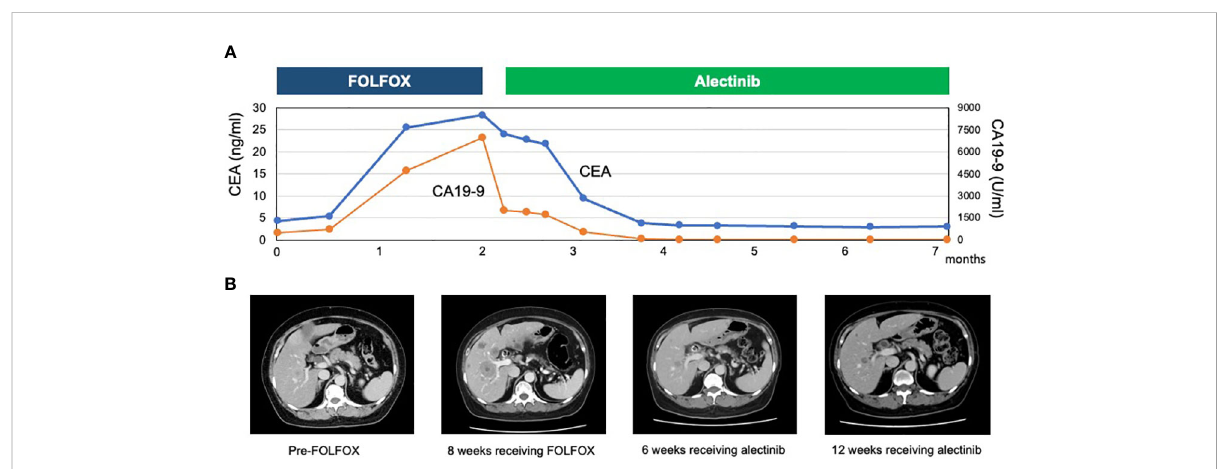
FIGURE 2 (A) Hematoxylin and eosin-stained biopsy specimen of the primary tumor. (B) Immunohistochemistry analysis showing strong ALK-positive